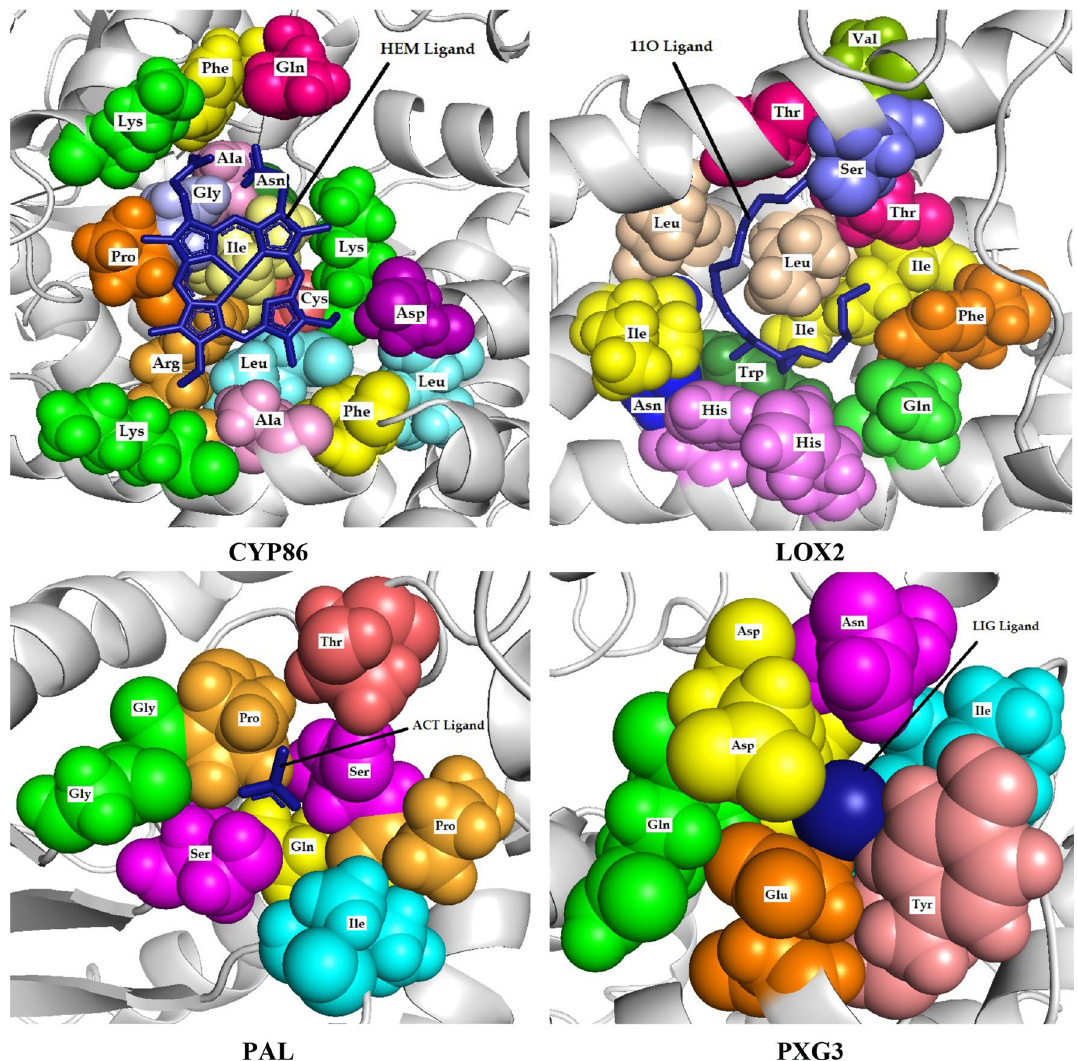
Figure 10. Interactions between the ligand and amino acids within 5A. Amino acids are shown as spheres and the ligands as cartoon representations. For better detection, each amino acid is shown with a specific